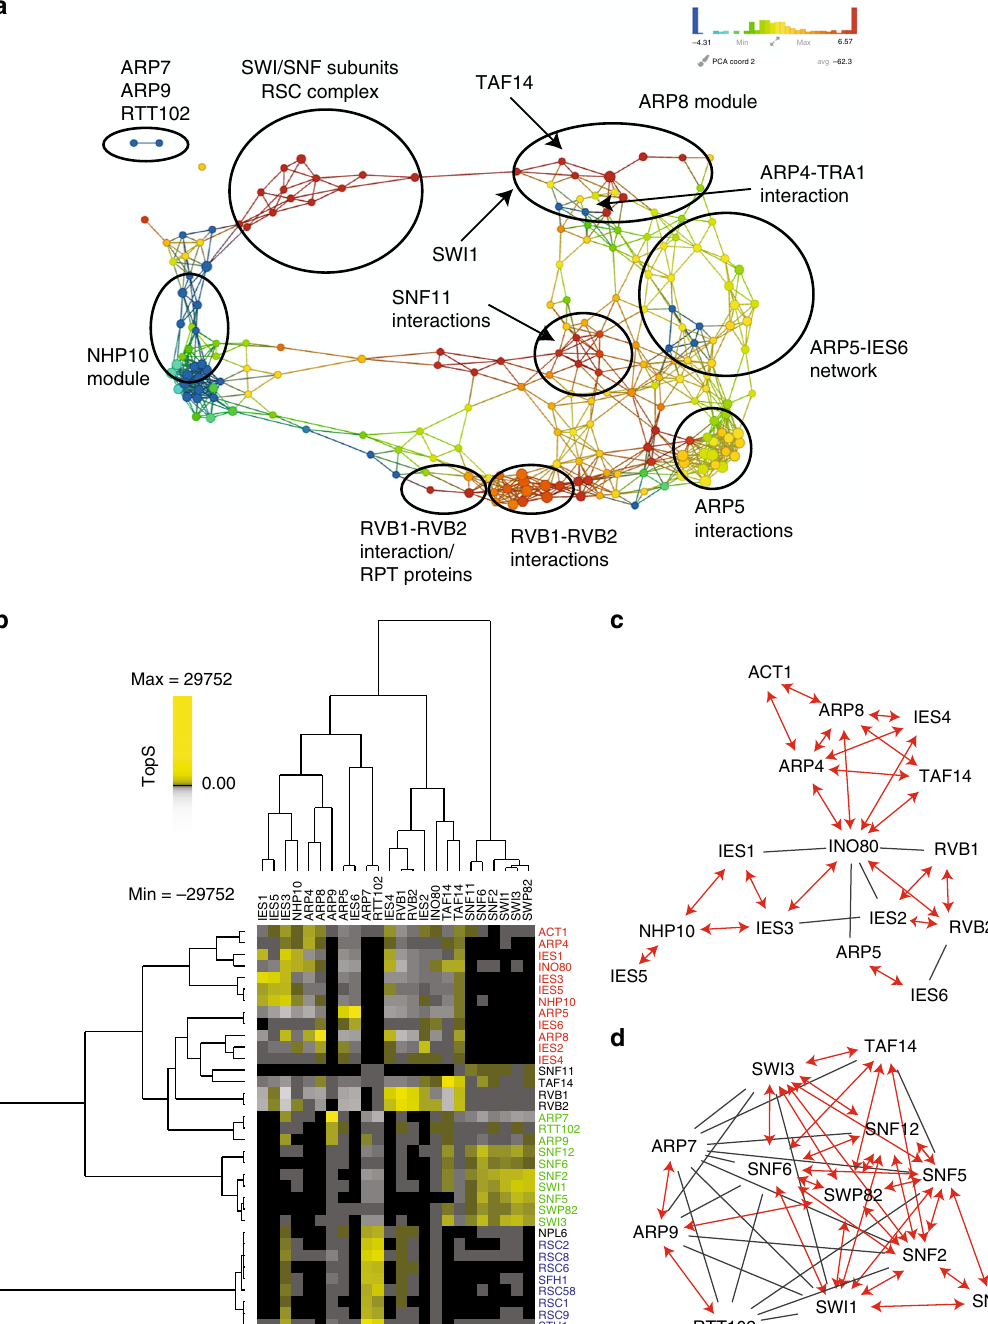
Fig. 6 Topological network and linkage analysis of a yeast chromatin remodeling network. a A TDA network was constructed for the yeast data inputting TopS scores to the Ayasdi platform 24 . Distance Correlation was used as a metric with two fi lter functions: Neighborhood lens 1 and Neighborhood lens 2. Resolution 50 and gain 6x eq. were used. Proteins are colored based on the rows per node. Color bar: red: high values, blue: low values. Node size is proportional with the number of proteins in the node. The location of protein complexes subunits within the topological network are drawn on top of the TDA output. b Hierarchical biclustering using TopS values. Components of the INO80, SWI/SNF, and RSC complexes were clustered using PermutMatrix 47 . Rows and columns were clustered using Pearson as the distance and Ward linkage as the method. Yellow corresponds to high TopS values and gray indicates negative TopS values. Proteins that are not present in the puri fi cations are shown in black. c , d Comparison of TopS values with crosslinking data. Each plot shows the direct interactions between subunits of c INO80 and d SWI/SNF. A red bidirectional edge represents the reported crosslinking interactions with a high TopS value. Black edges represent the reported crosslinking interactions with lower TopS values. TDA topological data analysis, TopS topological